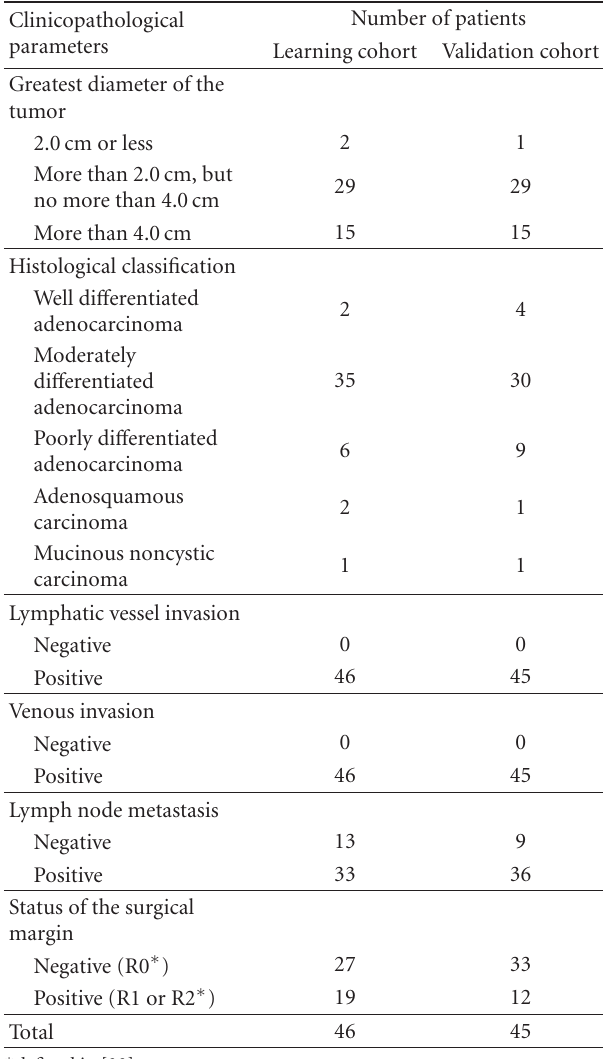
Table 1: Clinicopathological parameters of patients with ductal adenocarcinomas of the